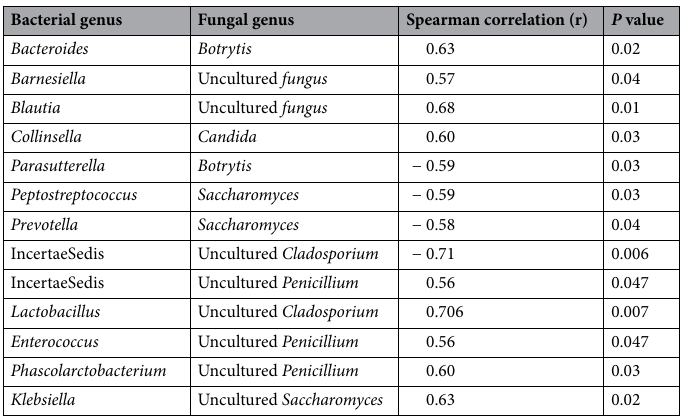
Table 2. Statistical tests assessing Spearman correlations between relative abundance of fungal and bacterial genera were performed at baseline (introduction to infliximab) in pediatric patients with inflammatory bowel disease who turned out to be non-responders to infliximab at the end of induction therapy (week